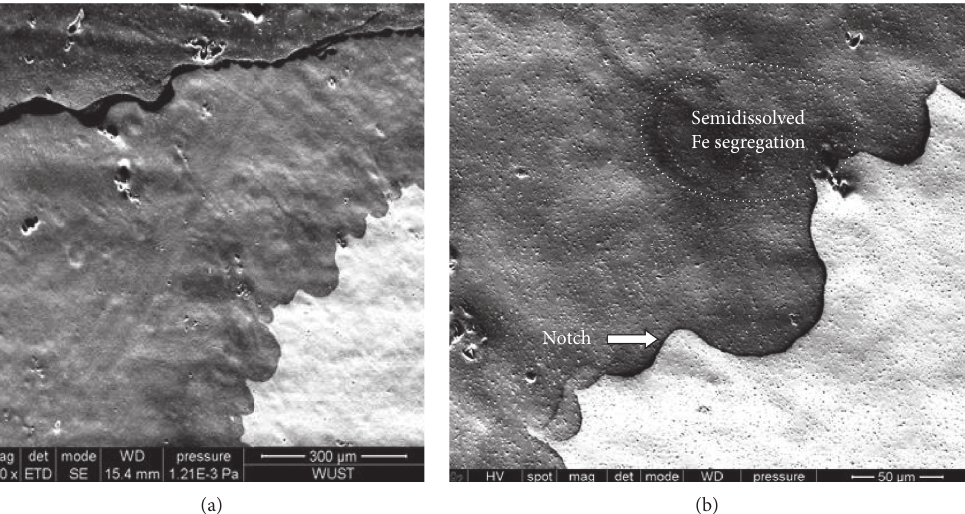
Figure 4: Fe precipitates at grain boundaries. (a) Three-layer structure of the abnormal grain boundary. (b) Partially dissolved particles at frontier of the grain boundary.